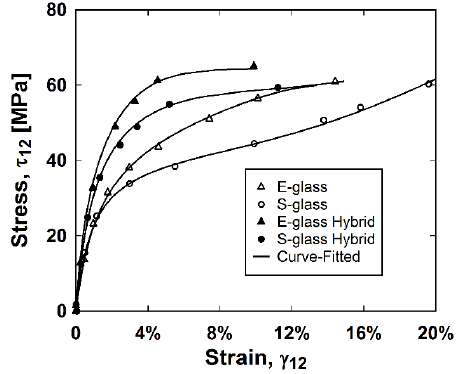
Figure 7. Experimental and curve-fitted shear stress – shear strain relationships.